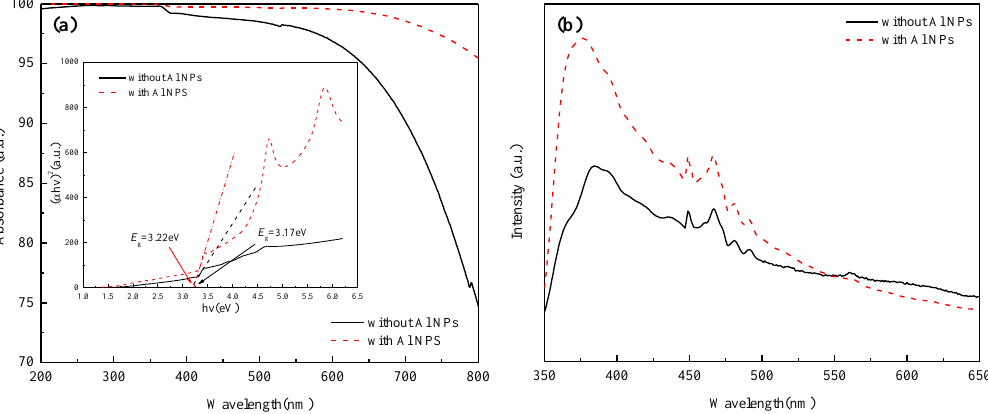
Figure 3. Absorbance spectra ( a ) and PL spectra ( b ) of ZnO NRs decorated with and without Al NPs.